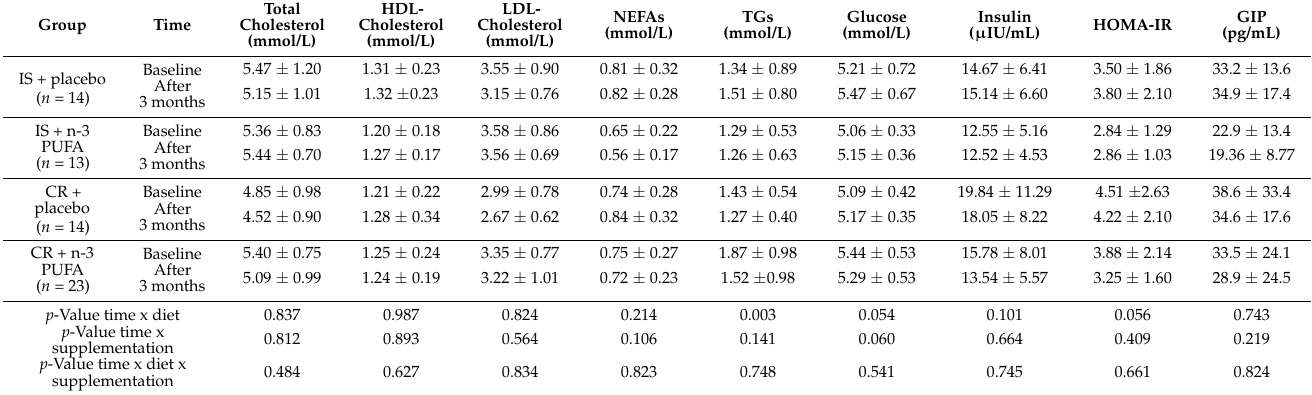
p -Value time x diet